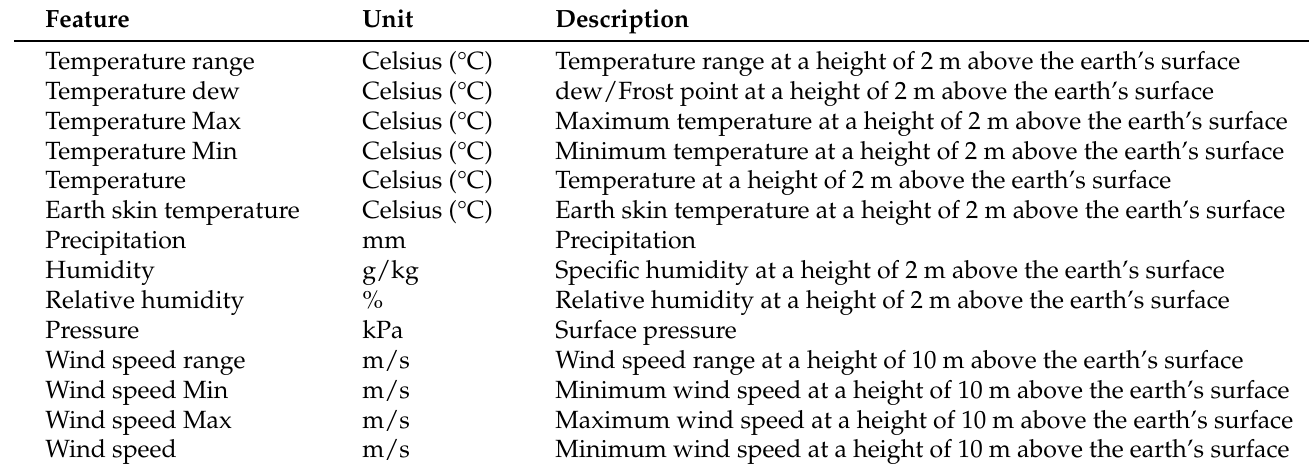
Table 4. Data feature of the our model.